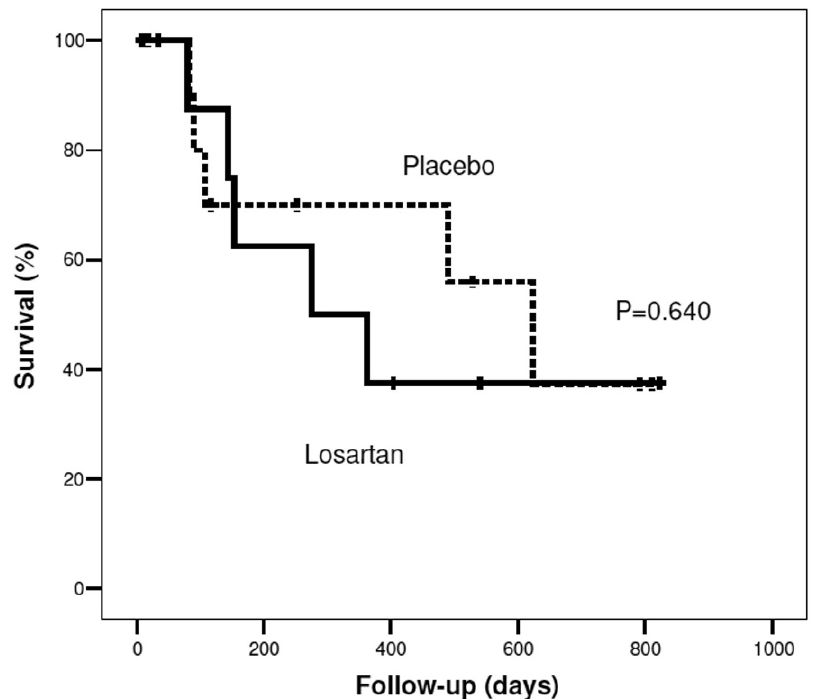
Figure 2 - Survival curves according to losartan or